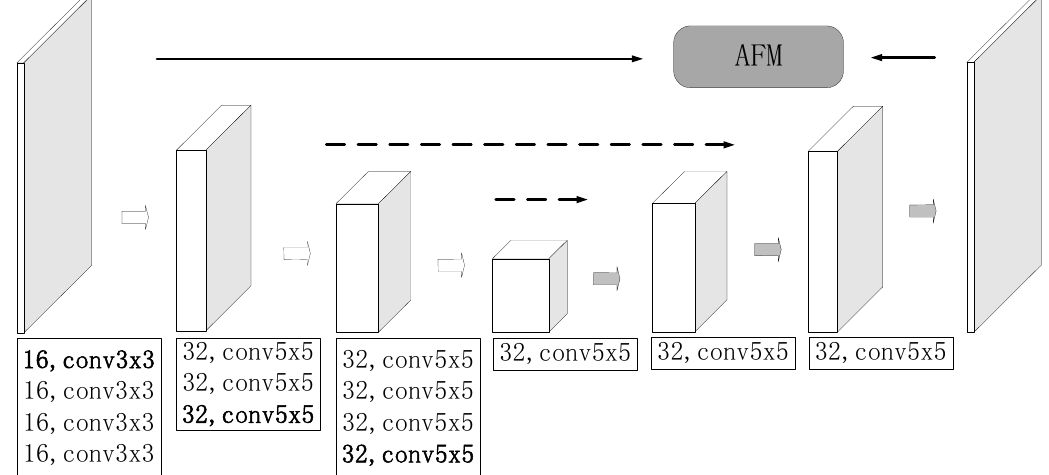
Figure 1. Segmentation network (AFM: Attention ‐ based fusion module).